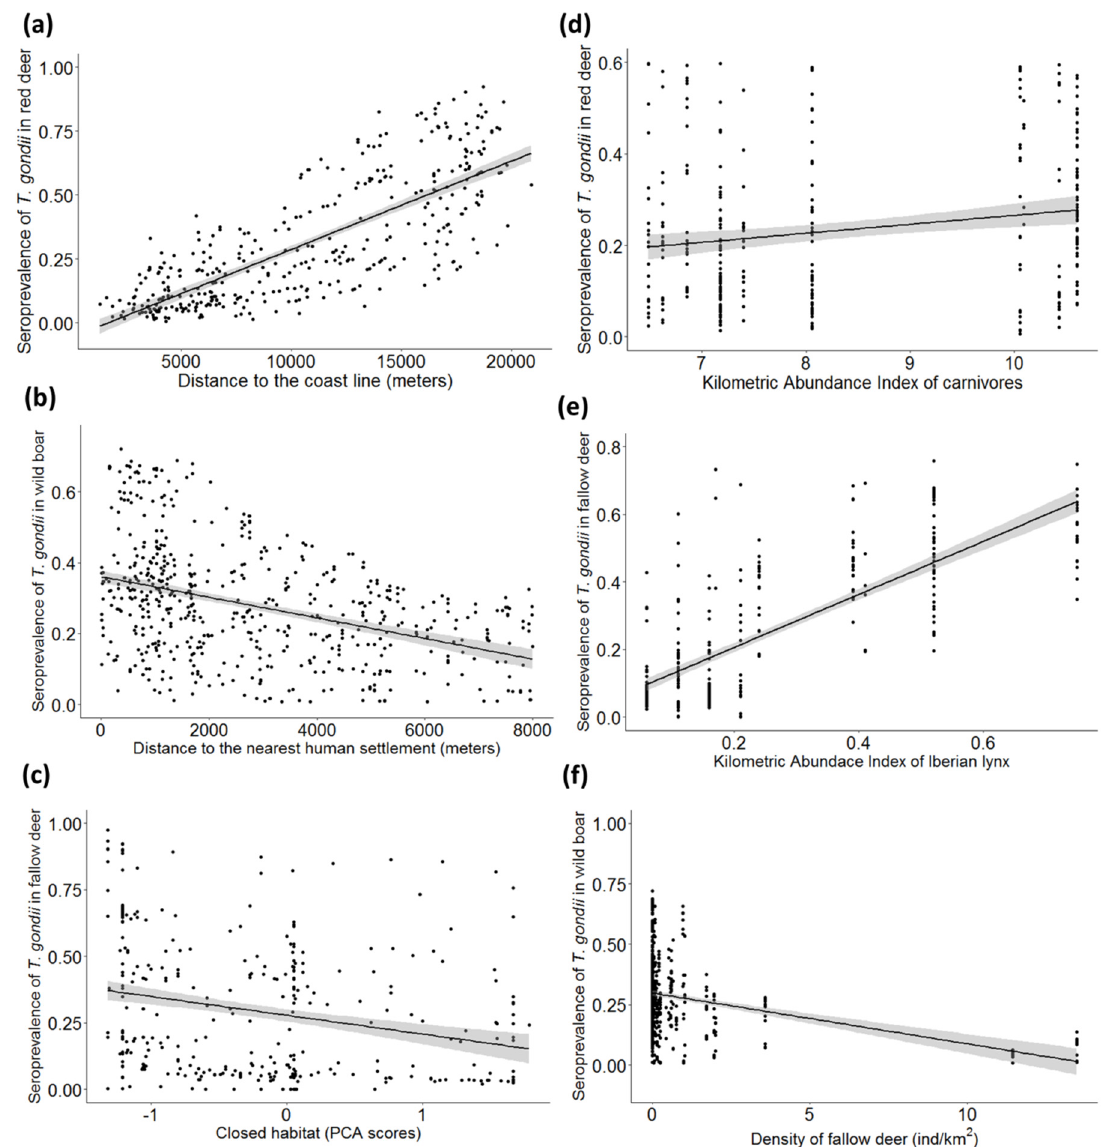
Figure 5. Seroprevalence ( ± CI 95%, represented by the shaded band) of Toxoplasma gondii obtained from selected generalized linear mixed models (GzLMMs) in ( a ) red deer depending on the distance to the coast line (m), ( b ) wild boar depending on the distance to the nearest human settlement (m), ( c ) fallow deer depending on the cover level of closed habitats, measured according to the principal component analysis (PCA) scores from axis 1, ( d ) red deer depending on the Kilometric Abundance Index of carnivores species (KAI), ( e ) fallow deer depending on the Kilometric Abundance Index of Iberian lynx (KAI), and ( f ) wild boar depending on the density of fallow deer (individuals/km 2 ).